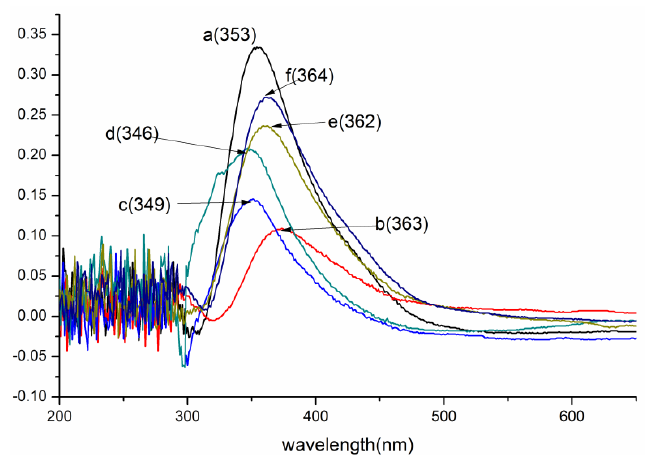
Figure 1. UV/Vis spectra of lignin and its esters: ( a ) original lignin; ( b ) acetylated lignin (1.5 h); ( c ) propionylated lignin (1.5 h); ( d ) butyrated lignin (2 h); ( e ) succinylated lignin (2 h); ( f ) maleylated lignin (2 h).